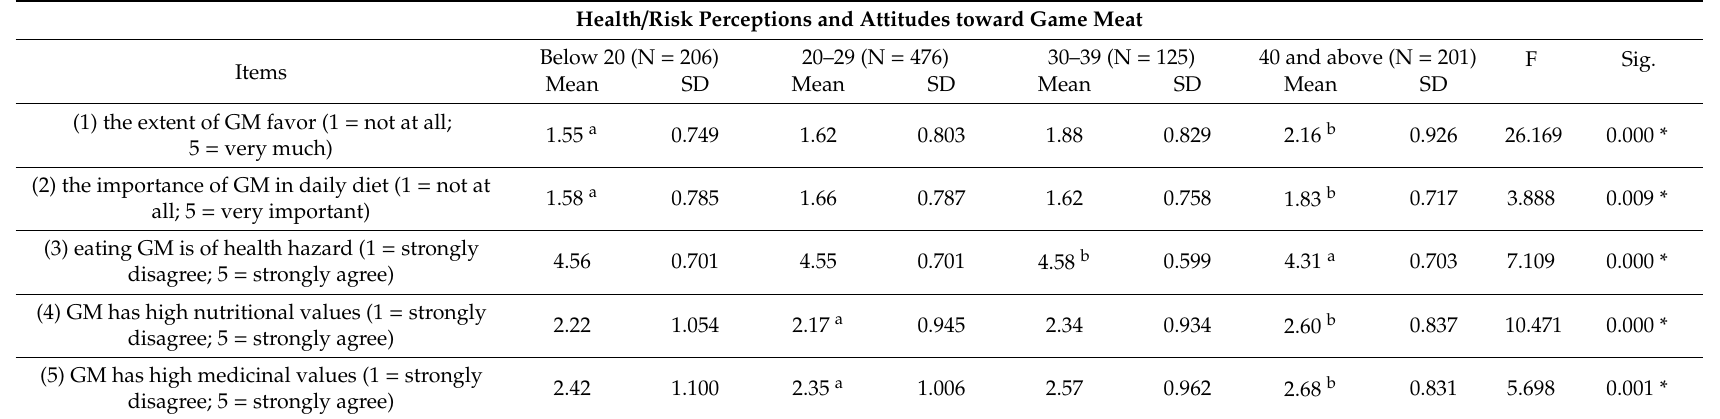
Table 3. The means, standard deviations, and F-tests of di ff erences of the measurement “health / risk perceptions and attitudes toward game meat” across age.